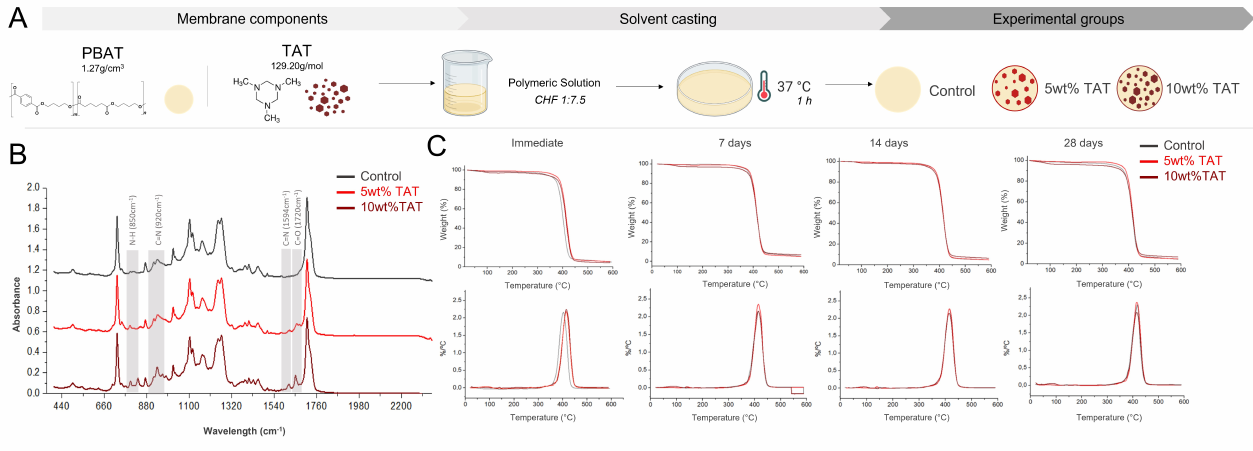
Figure 1. ( A ) Schematics of membrane fabrication via solvent casting. Chemical characterization of developed materials by ( B ) FTIR analysis with the characteristic bands in TAT and ( C ) the thermal behavior of experimental barrier membranes before and after immersion in